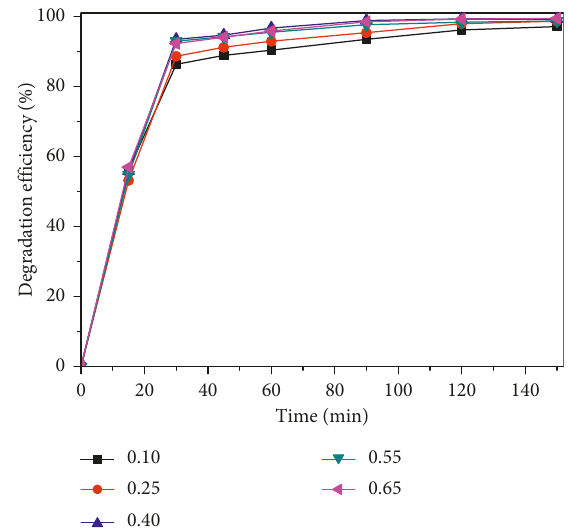
Figure 6: Comparative study on catalytic activity of Zn-HA samples with different zinc substitution degrees.